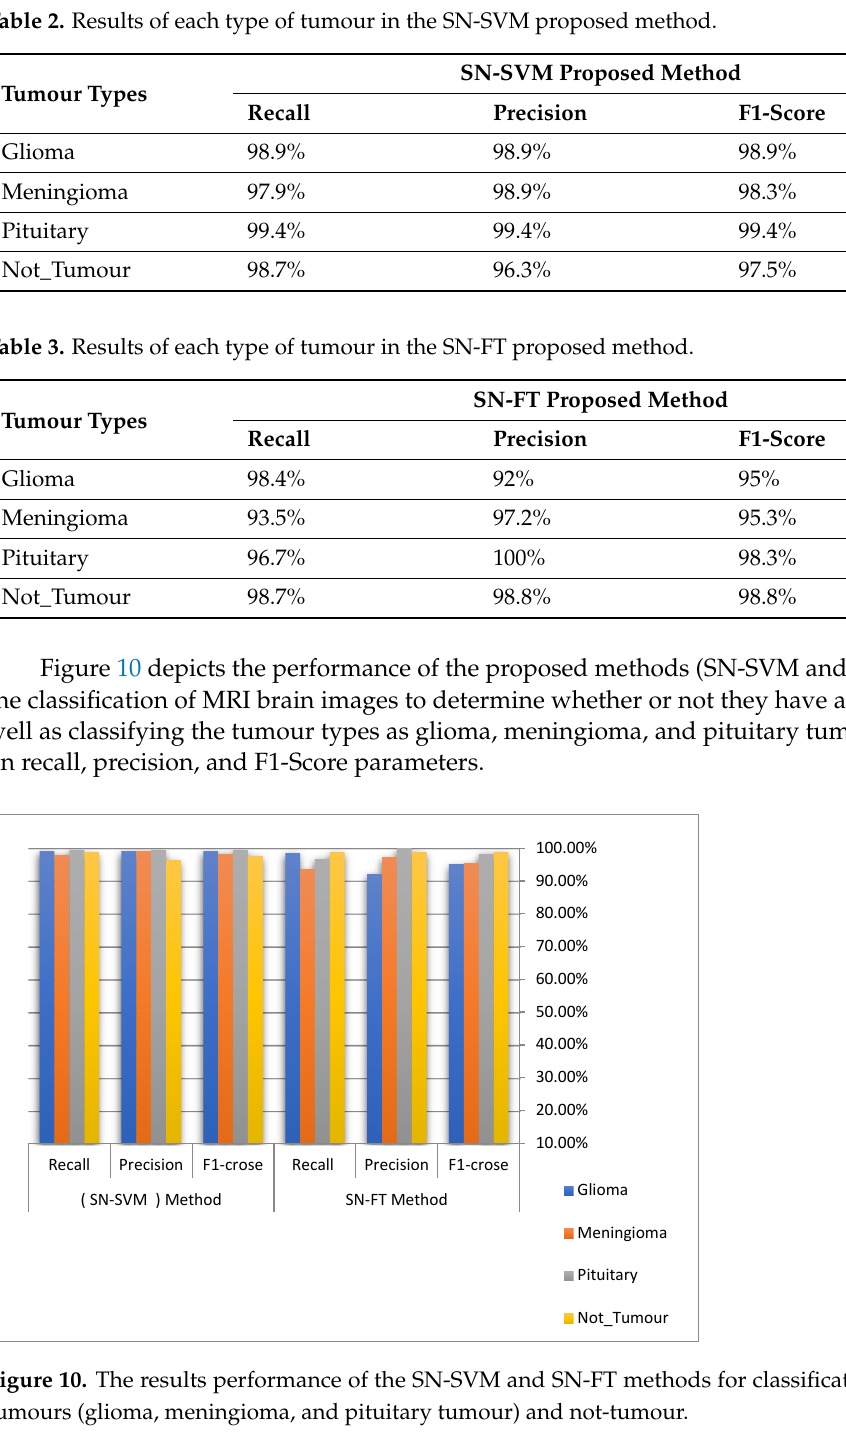
Table 4. Results of the performance of the SN-SVM and SN-FT methods. SqueezeNet technique with the SVM technique (SN-SVM) Recall